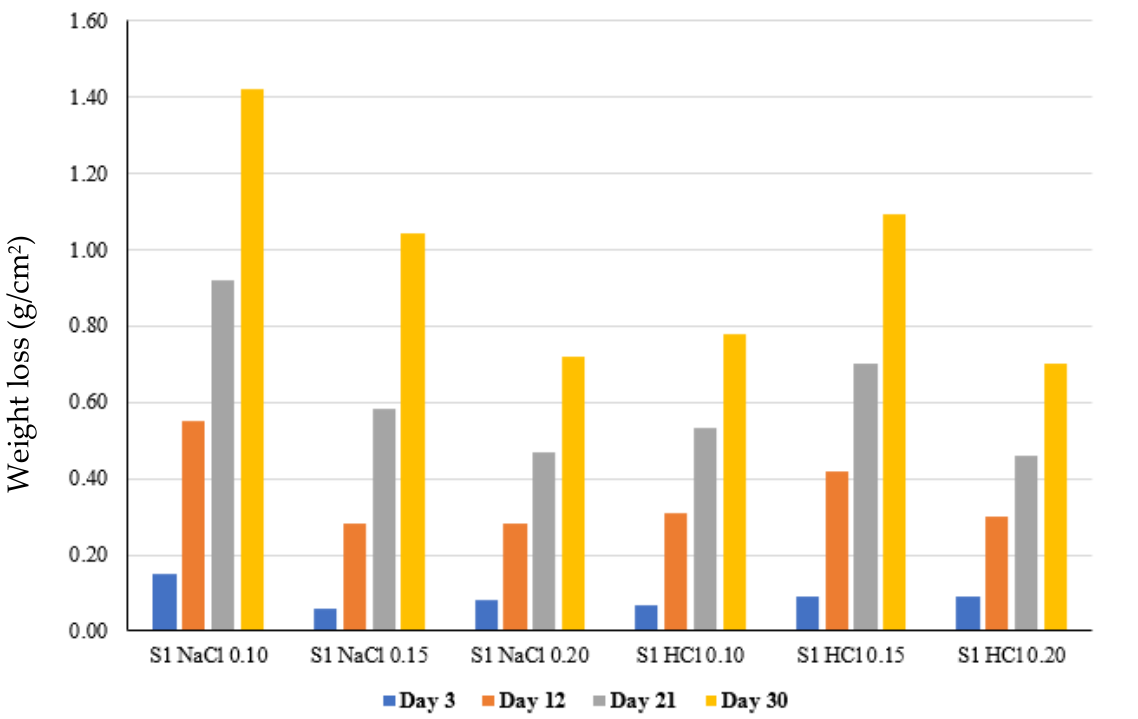
Figure 1. Effect of AgNp + CaCO 3 on corrosion behaviour of S 1 (2%).